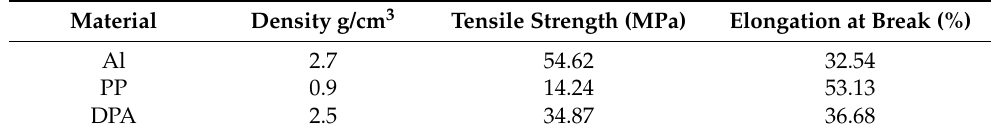
Table 1. Physical properties of the Al, PP, and GF materials.